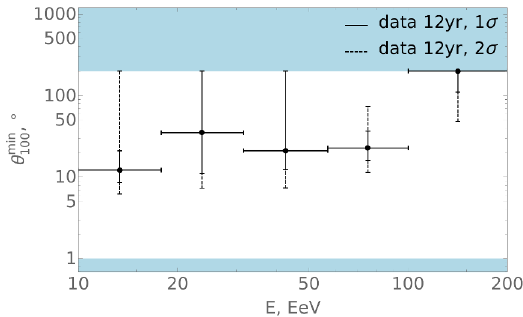
Figure 3. The positions of the TS minima, as well as the corre- sponding 1- and 2- σ intervals, for the actual TA data in 5 energy